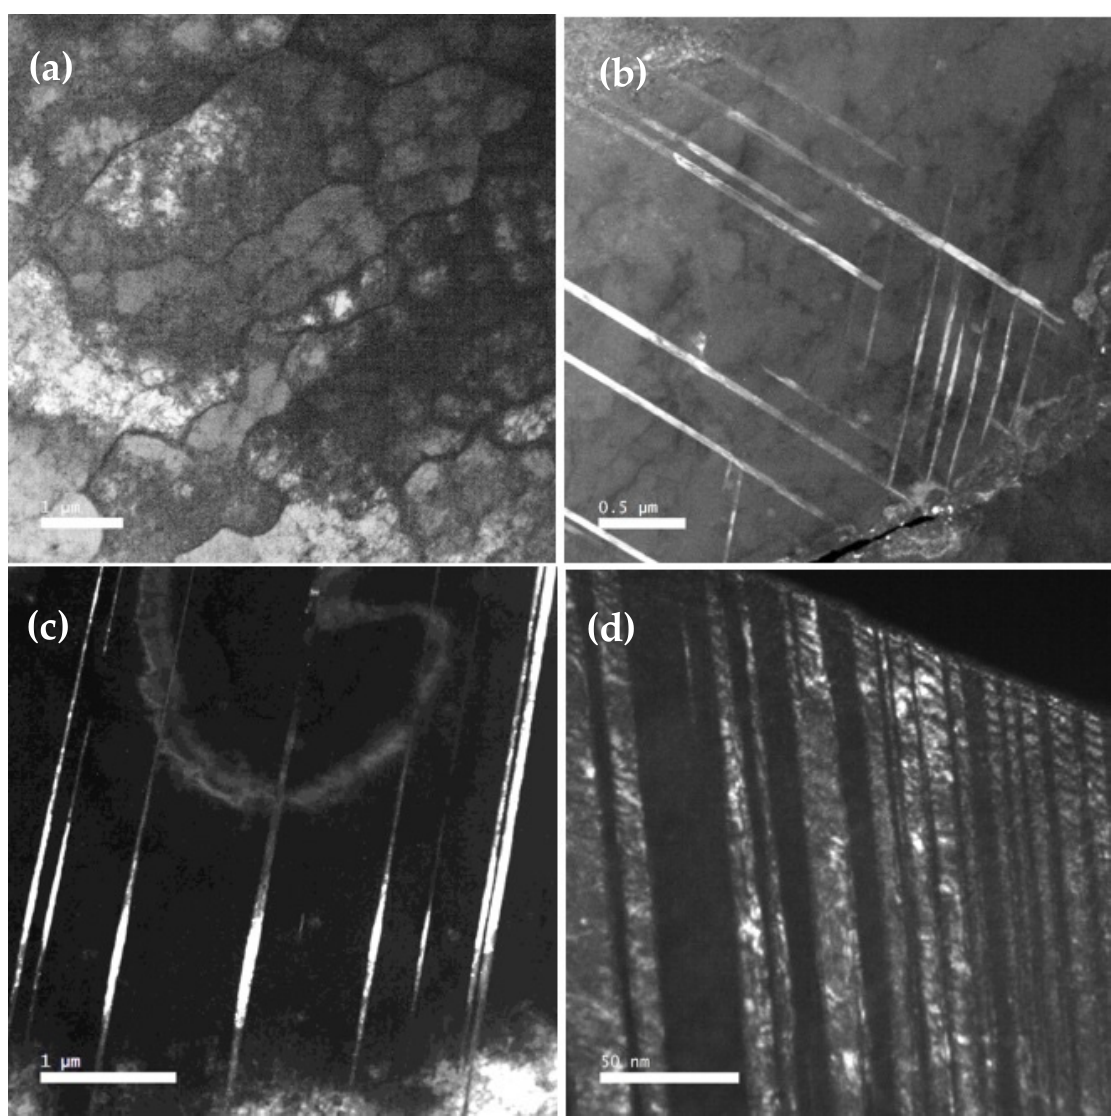
Figure 6. Microstructure of the studied samples, TEM images: ( a ) as-built; ( b ) 8 × 10 − 4 s − 1 , ( c ) 3 × 10 − 3 s − 1 , and ( d ) 2 × 10 − 2 s − 1 .